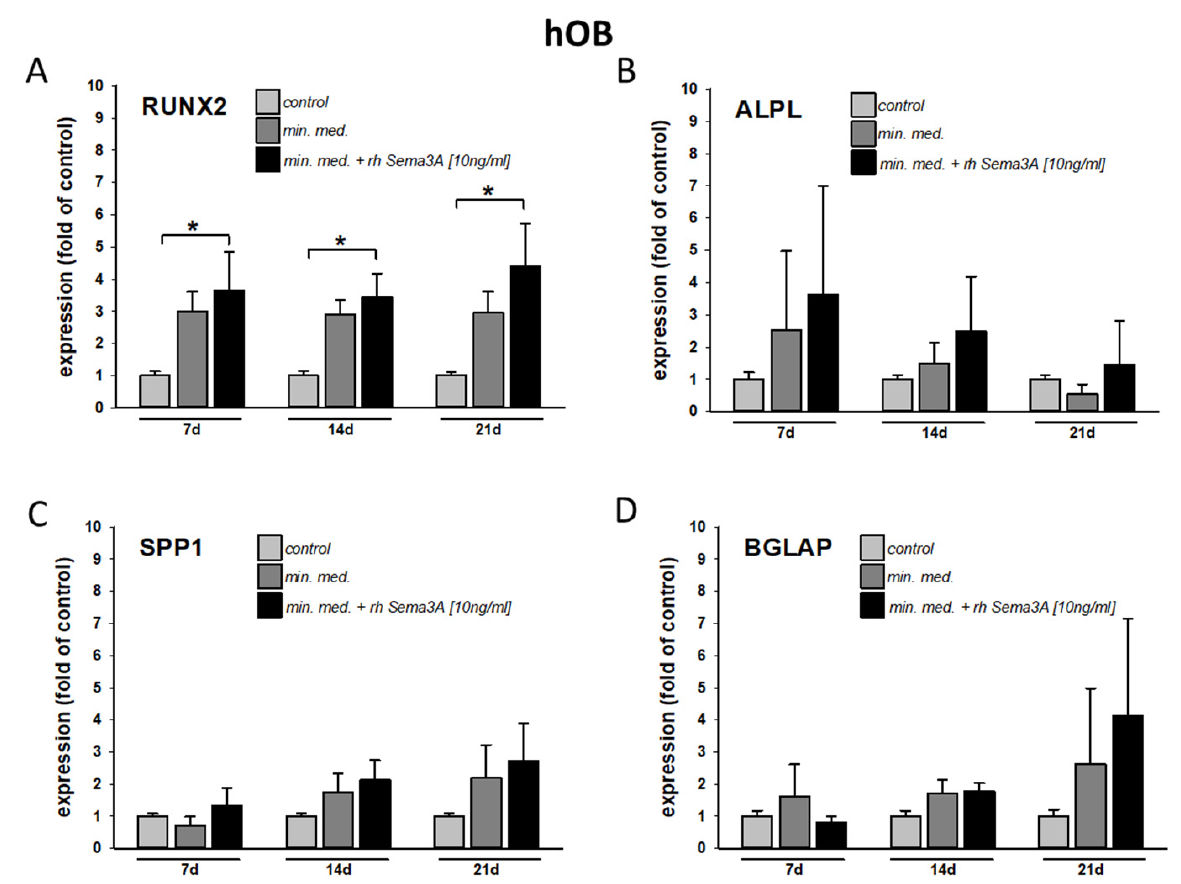
Figure 5. Exogenous Semaphorin 3A stimulation contributes to the osteogenic differentiation of osteoblasts of the alveolar bone (hOB) in an already osteogenic environment. Three independent populations of primary human osteoblasts of the alveolar bone were cultivated with osteogenic differentiation medium with and without the addition of recombinant Semaphorin 3A [10 ng/mL] for 7–21 days. After 14 and 21 days, Semaphorin 3A increased the expression of osteogenic marker genes: RUNX2 ( A ), ALPL ( B ), SPP1 ( C ) and BGLAP ( D ). Experiments were carried out in triplicate. Untreated cells served as controls. Quantitative RT-PCR experiments were carried out in triplicate. Cumulative data of the three cell populations data are given as mean ± SD. * = p < 0.05 vs. control (Kruskal–Wallis one-way analysis of variance on ranks (ANOVA), followed by Dunn’s post-hoc